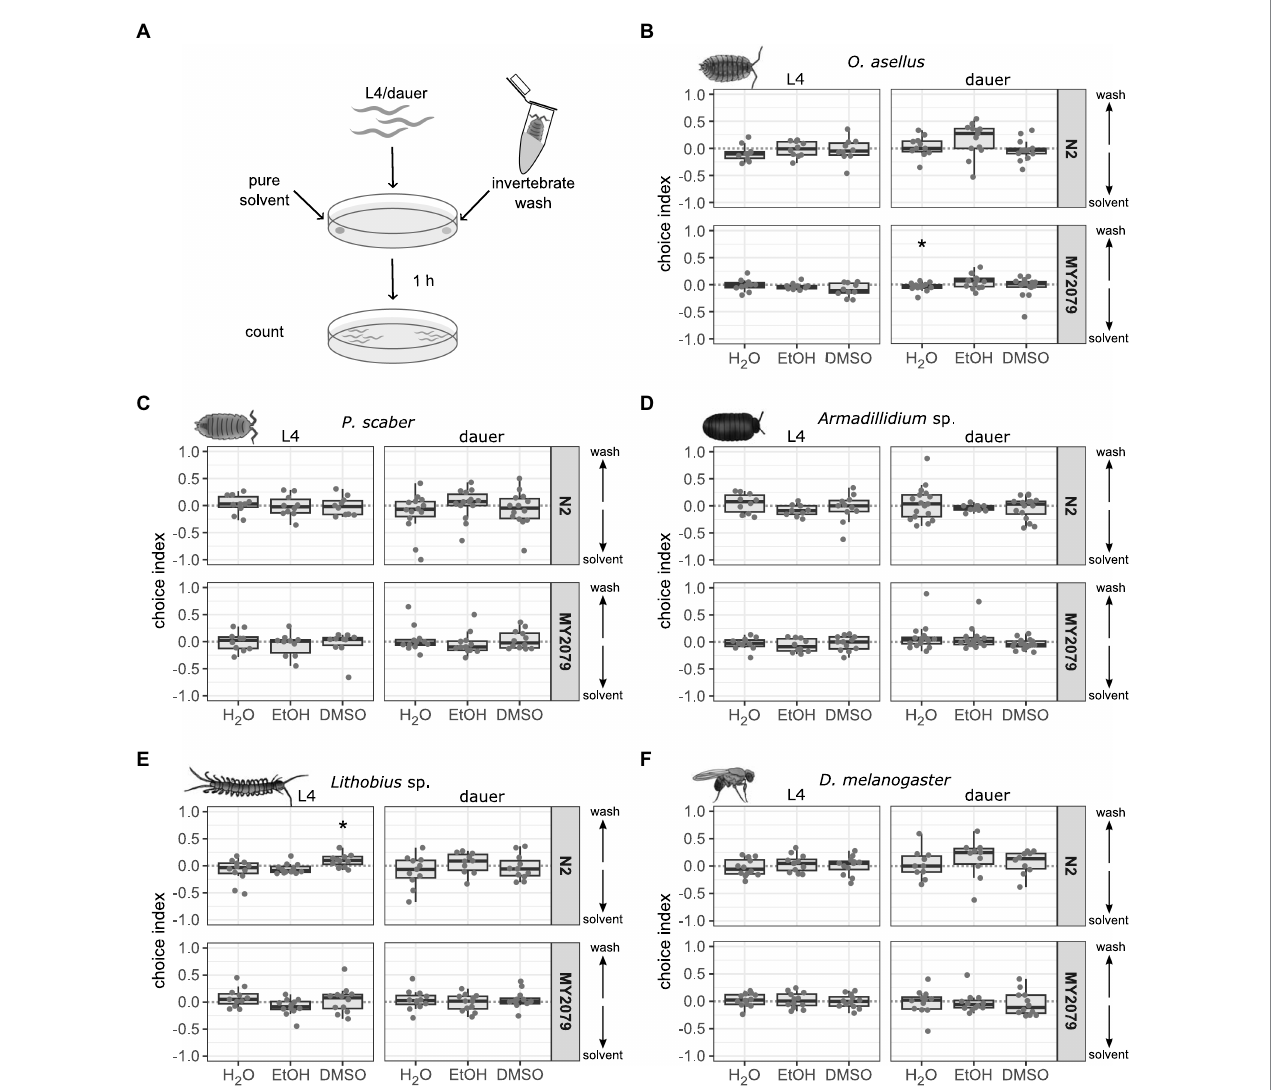
FIGURE 1 Caenorhabditis elegans strains N2 and MY2079 do not respond to most invertebrate washes with three different solvents. (A) Caenorhabditis elegans strains N2 and MY2079 were grown on OP50 and used as L4 or dauer larvae to evaluate their chemotactic response toward washes of potential invertebrate migration partners in three different solvents. A positive choice index indicates attraction to the invertebrate wash from (B) Oniscus asellus ( n = 10–17), (C) Porcellio scaber ( n = 10–16), (D) Armadillidium sp. ( n = 10–20), (E) Lithobius sp. ( n = 10–15), and (F) Drosophila melanogaster ( n = 11–12). A negative choice index indicates repulsion from the invertebrate wash, a choice index of 0 indicates equal choice of both sides. For comparison of choice indices with 0, the Wilcoxon signed-rank test with false discovery rate correction for multiple testing was applied. Data are presented as boxplots with the median as a thick horizontal line, the interquartile range as box, the whiskers as vertical lines, and each replicate depicted by a dot. Significance is designated to * p < 0.05. From left to right each panel shows boxes representing deionized water (H 2 O), ethanol (EtOH), or dimethyl sulfoxide (DMSO) washes (with 30–250 worms per